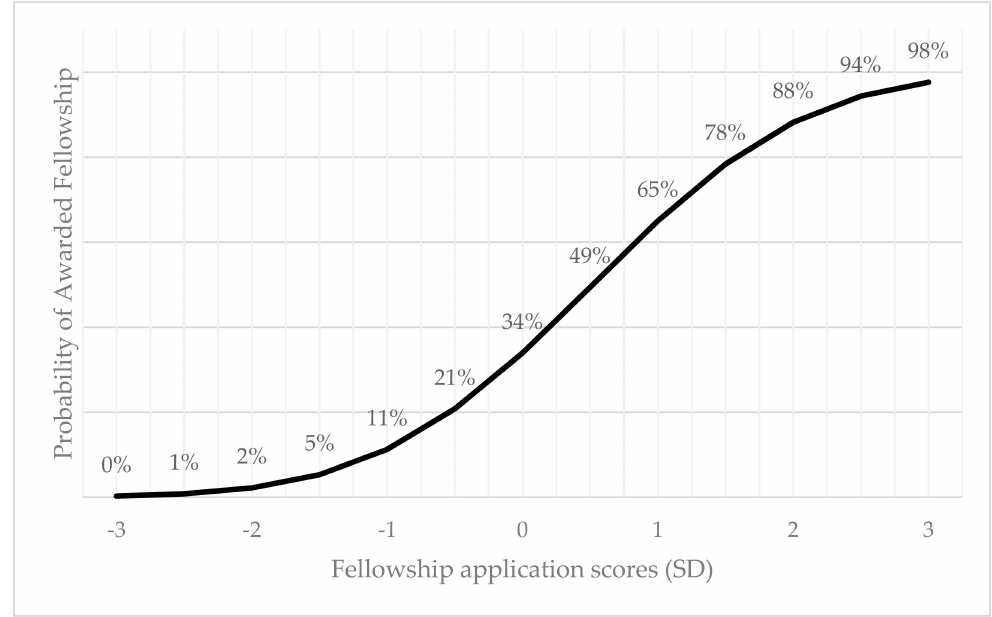
Figure 2. Non-linear response of predicted probabilities of awarded fellowship to changes in fellowship application scores in